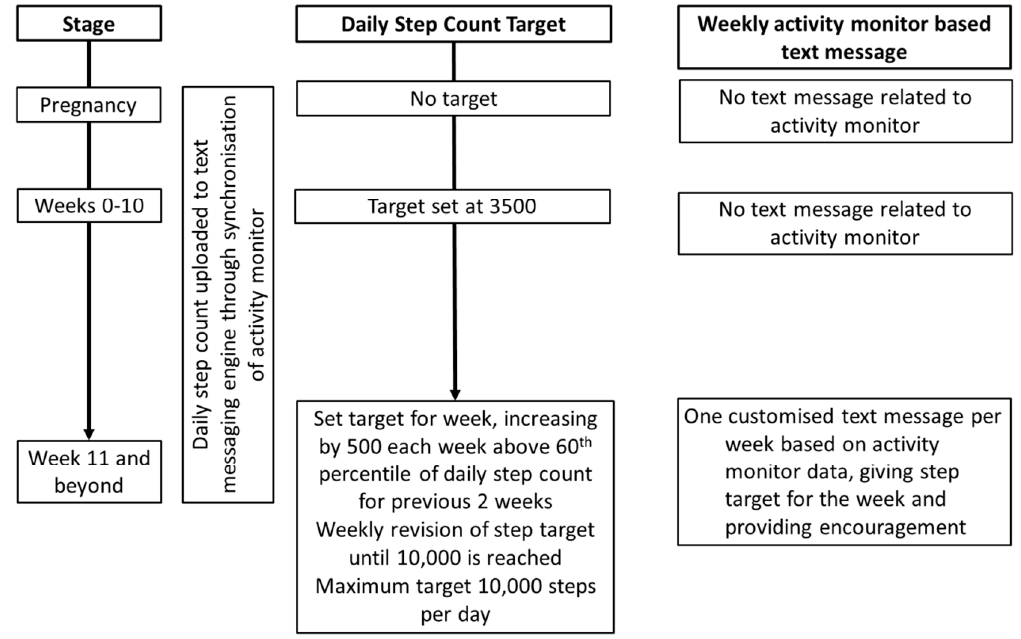
Figure 2. Algorithm for setting adaptive step targets. The step target was set on a weekly basis, based on data uploaded from the activity monitor, and the woman informed through text messaging.